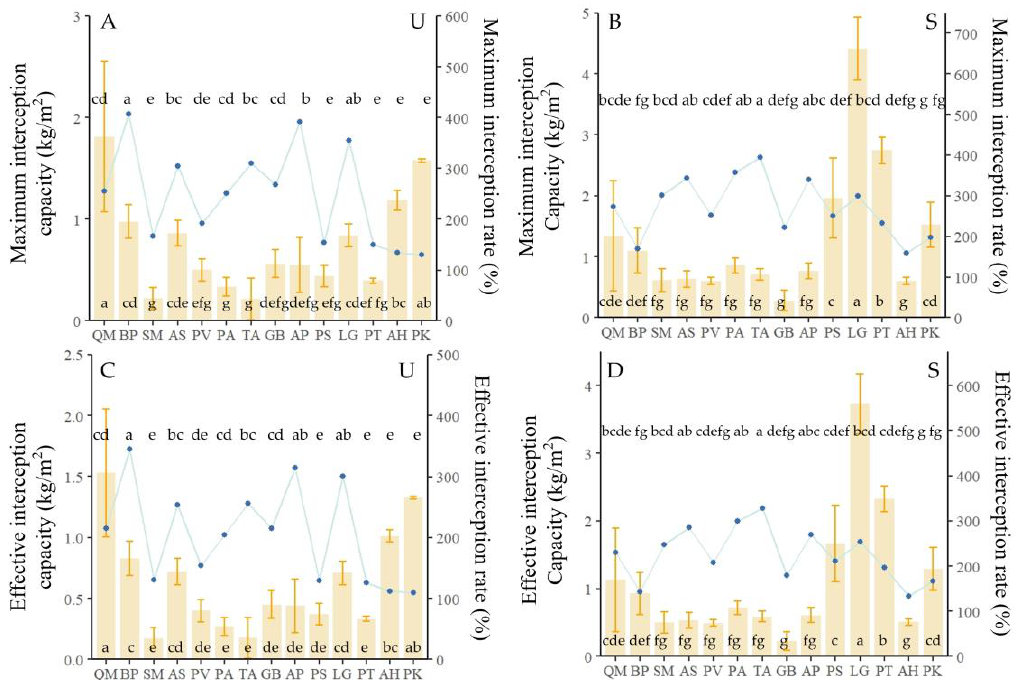
Figure 3. Litter water interception characteristics of different decomposed layers. ( A , B ) show the maximum interception capacity of 14 tree species litters in two decomposed layers, and ( C , D ) show the effective interception capacity of 14 tree species litters in two decomposed layers Note: The bars are the values of maximum interception capacity or effective interception capacity, while the dots are the values of maximum interception rate or effective interception rate. Different lowercase letters within the bars indicate significant differences of water maximum interception capacity or effective interception capacity among tree species at the 0.05 level, and the lowercase letters above the dots indicate significant differences of water maximum interception rate or effective interception rate among tree species at the 0.05 level. U indicates un-decomposed layer and S indicates semi-decomposed layer. The abbreviation of tree species is the same as Table 1.